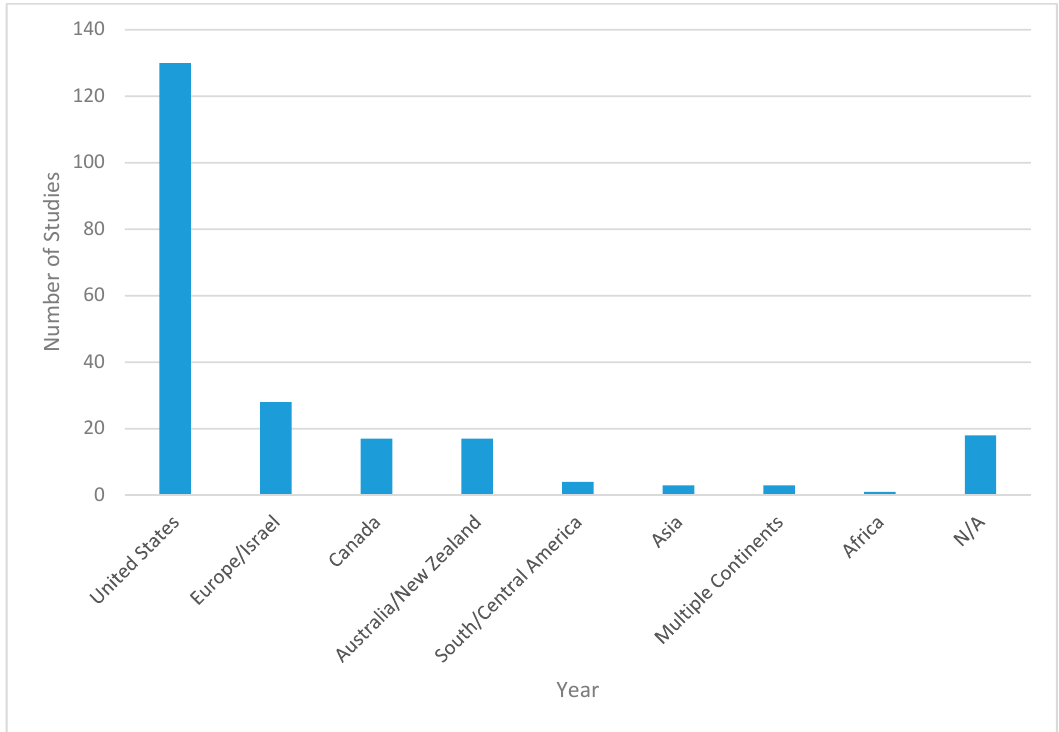
Figure 3. Distribution of studies considered in this review by study design.